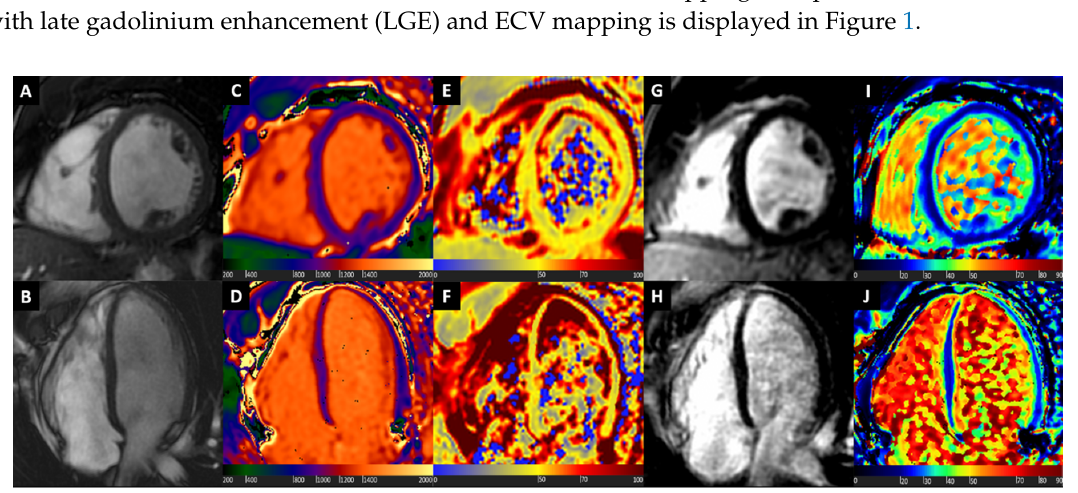
Figure 1. Normal heart. Basal short axis view (Box A ) and 4-chamber long axis view (Box B ) balanced steady state free precession images showing normal biventricular size and wall thickness. Normal T1 values at native T1 mapping images (Boxes C and D ). Normal T2 values at T2 mapping (Boxes E and F ), excluding the presence of oedema. Late gadolinium enhancement (LGE) images show uniform myocardial suppression (Boxes G and H ). Normal extracellular volume (ECV) values at ECV mapping (Boxes I and J ).